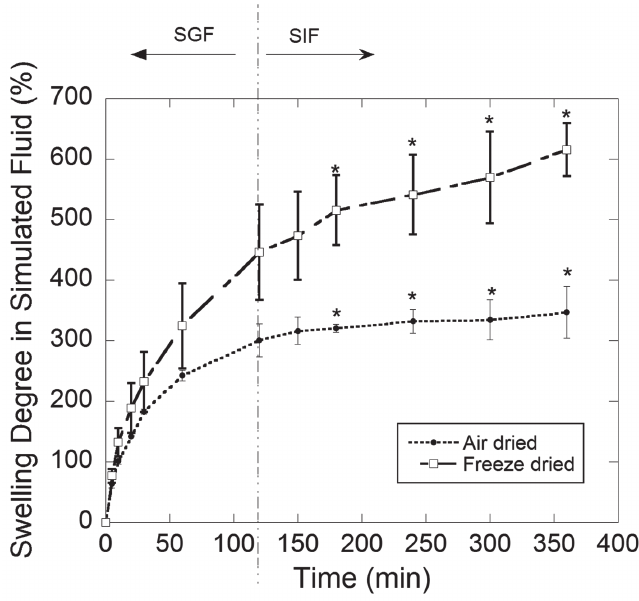
Figure 2 - Swelling degree of the gelatin hydrogels in free enzyme gastric (SGF) and intestinal (SIF) simulated fluids: (●) air-dried (ADH) and (□) freeze-dried (FDH); *significant difference (p <